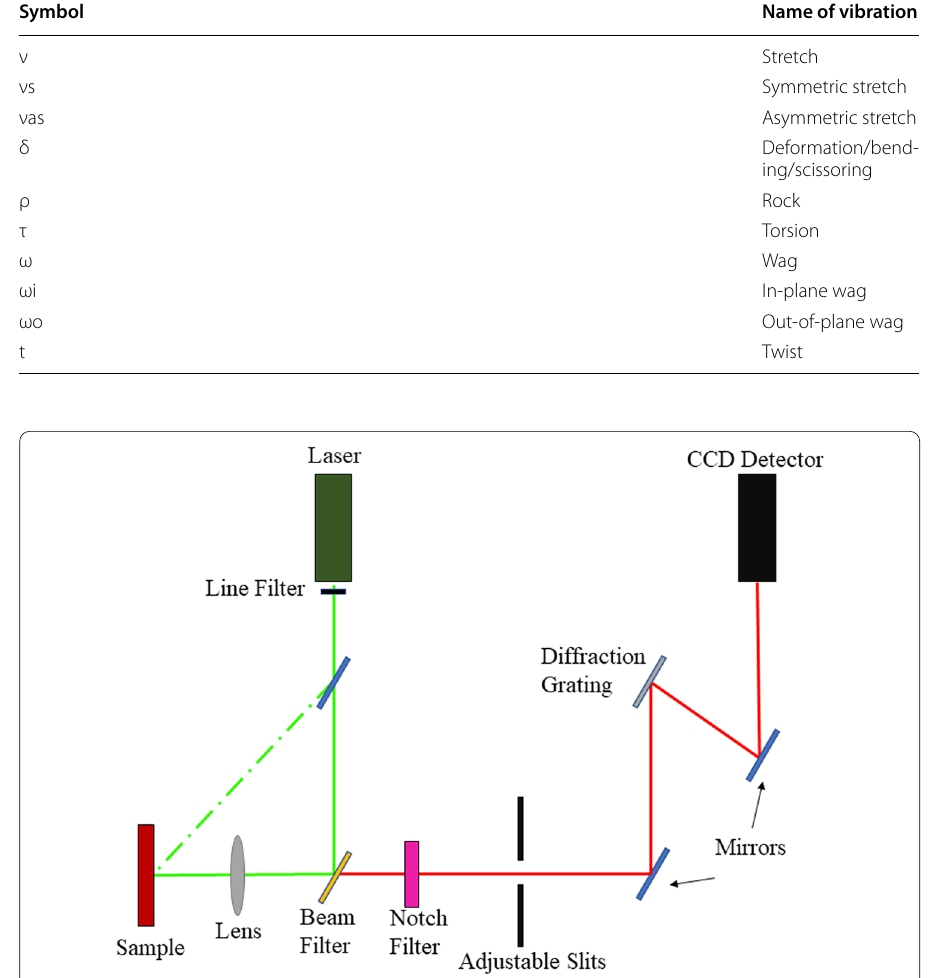
Fig. 4 The basic components in a conventional Raman